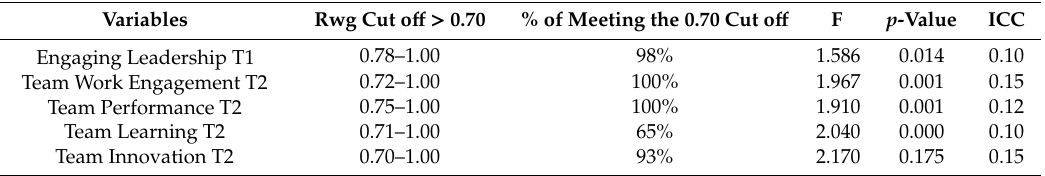
Table 2. Aggregation Statistics for Individual-Level Variables (Individual Level, N = 224, Team Level, N =